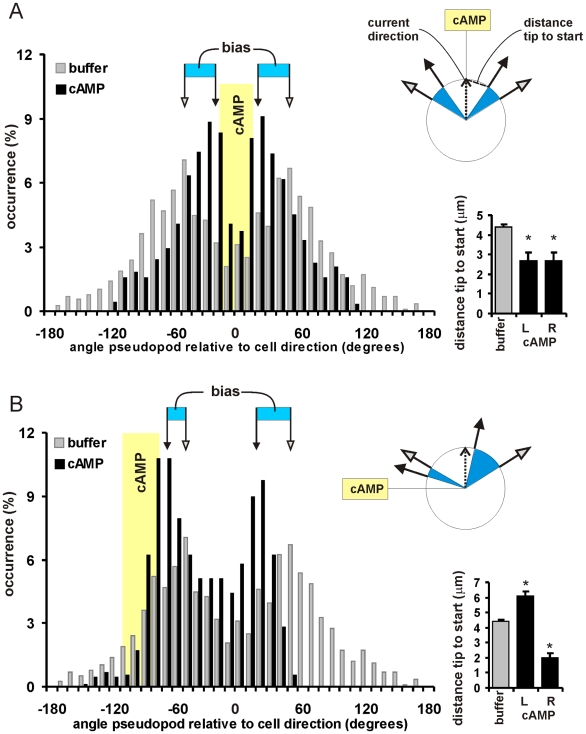
Orientation of Dictyostelium cells in shallow gradients.From a large data set of pseudopodia that are extended by freely moving cells in a cAMP gradient (see supplemental figure S2 for large data set), we selected those cells whose current direction of movement is either in the direction of the cAMP gradient (−20 to + 20 degrees), or at an angle of ∼90 degrees relative to the gradient (−70 to −110 degrees). The position of the cAMP gradient is shown by the yellow bar. The main figures show the histograms of the angles between current pseudopod and next pseudopod. In buffer this angle has a bi-symmetric distribution with 55 +/− 28 degrees to the left or right (grey bars; mean and SD, wrapped von Mises distribution). If the current direction is towards cAMP (panel A, solid bars), the distribution of angles is also bi-symmetric but at a smaller mean and smaller SD (30 +/− 18 degrees), leading to a bias towards cAMP (blue area). If the cAMP gradient is at an angle of ∼90 degrees to the left relative to the current direction (panel B), the next pseudopod exhibits an asymmetric bias towards cAMP with −70 +/− 23 degrees for the left pseudopod and 18 +/− 20 degrees for the right pseudopod. The inset bar graphs show the distance between the tip of the present pseudopod to the start of the next pseudopod; *, significantly different from buffer at P<0.01. The inset schematics show a circular cell with radius 5 um. The observed distance between tip and start predicts where on the surface the next pseudopod starts. The pseudopod arrows are drawn perpendicular to the curvature, as is observed experimentally.